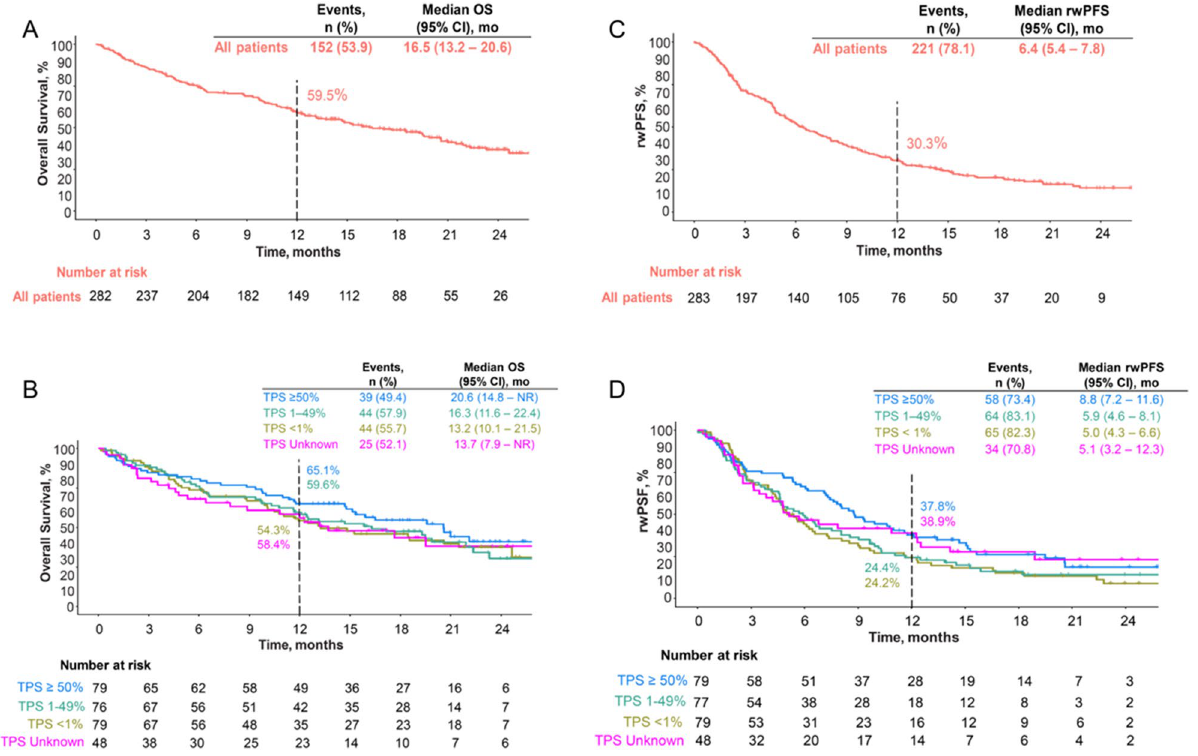
Figure 3. Overall survival (OS) and real-world progression-free survival (rwPFS): ( A ) OS for all patients, ( B ) OS by PD-L1 tumor proportion score, ( C ) rwPFS overall, ( D ) rwPFS by PD-L1 tumor proportion score.